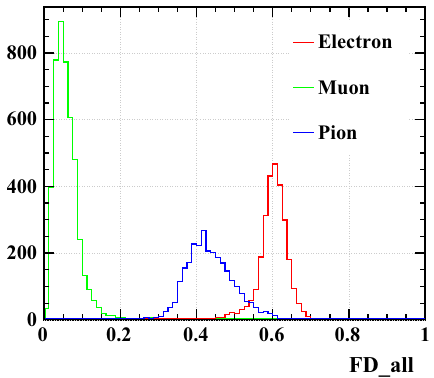
Fig. 1 dE/dx for e − , μ − and π + , for electrons it is stable around 2 . 4 × 10 − 7 , for muon and pion it is smaller at energy lower than 10 GeV and after that they start mixing with electron (first 7% and last 30%). The dE/dx has a strong discrim- inant power to distinguish electron tracks from others at low energy (under 10 GeV) (Fig. 1).